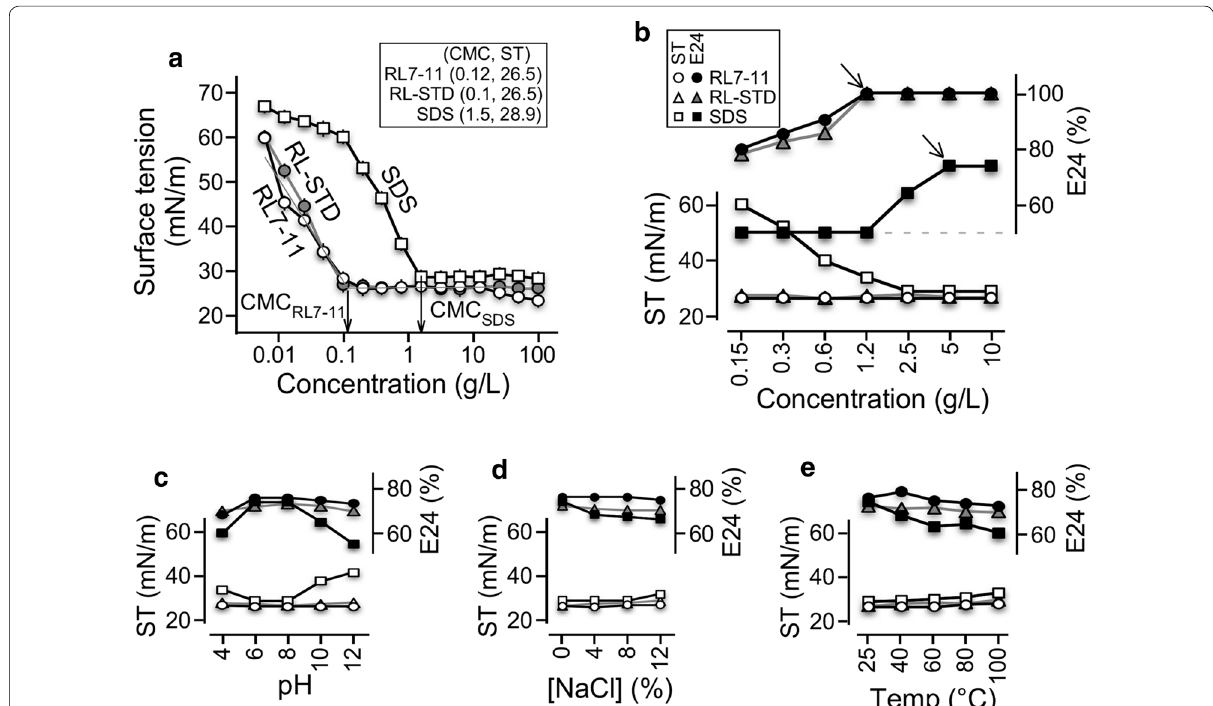
Fig. 5 Comparative analysis of surfactant activity between RL7-11, RL-STD, and SDS. a Analysis of CMC-RL7-11, CMC-RL-STD, and CMC-SDS. X - and Y -axis indicate surfactant concentration in g/l and surface tension in mN/m, respectively. b Analysis of surface tension and emulsification capacity E24 index against crude oil. Solid and open marks indicate surface tension in mN/m and E24 index in percent. Circle , triangle , and square indicate RL7-11, RL-STD, and SDS, respectively. Analysis of surfactant activity under various pH, salinity, and temperature conditions is shown in c , d and e , respectively. The display is identical to